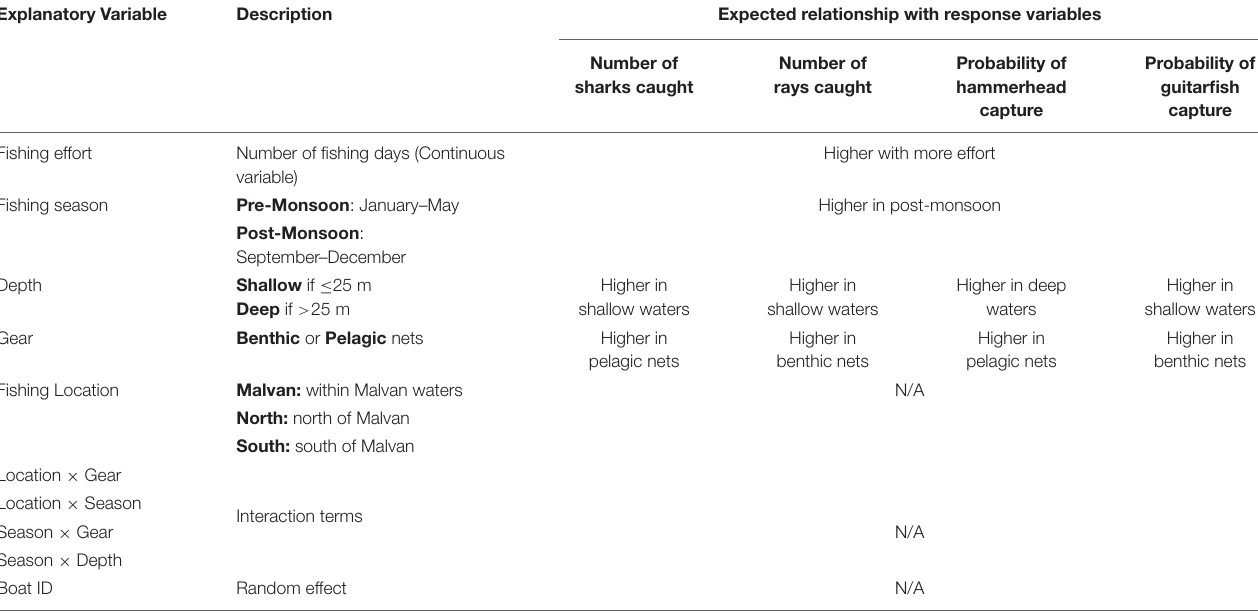
TABLE 2 | The different fishing factors and interactions used as explanatory variables in the